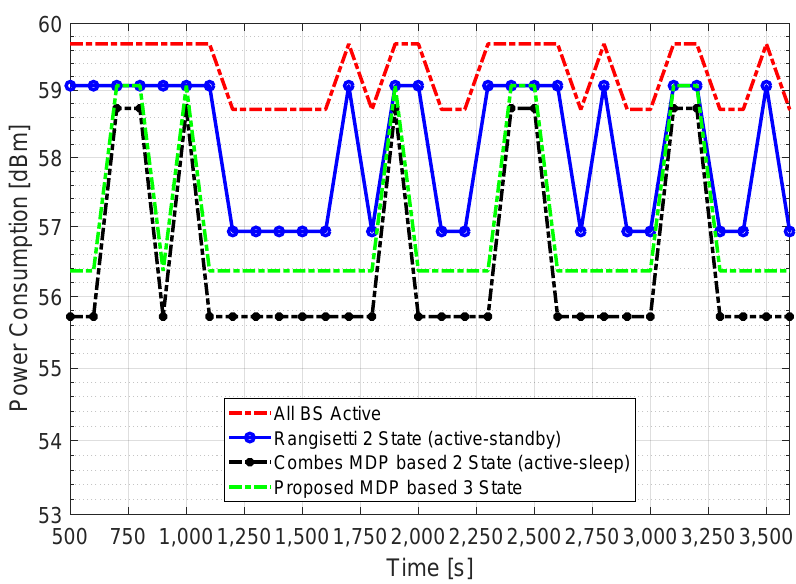
Figure 6. Power consumption of the network for different